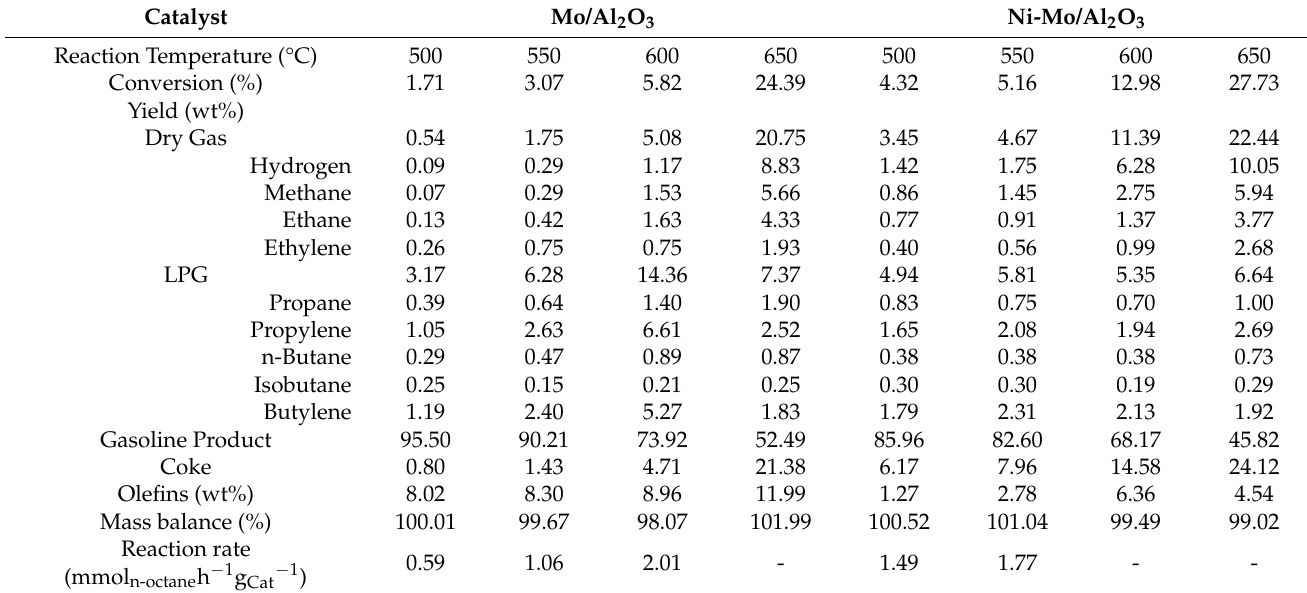
Table 2. The product distribution of Mo/Al 2 O 3 and Ni-Mo/Al 2 O 3